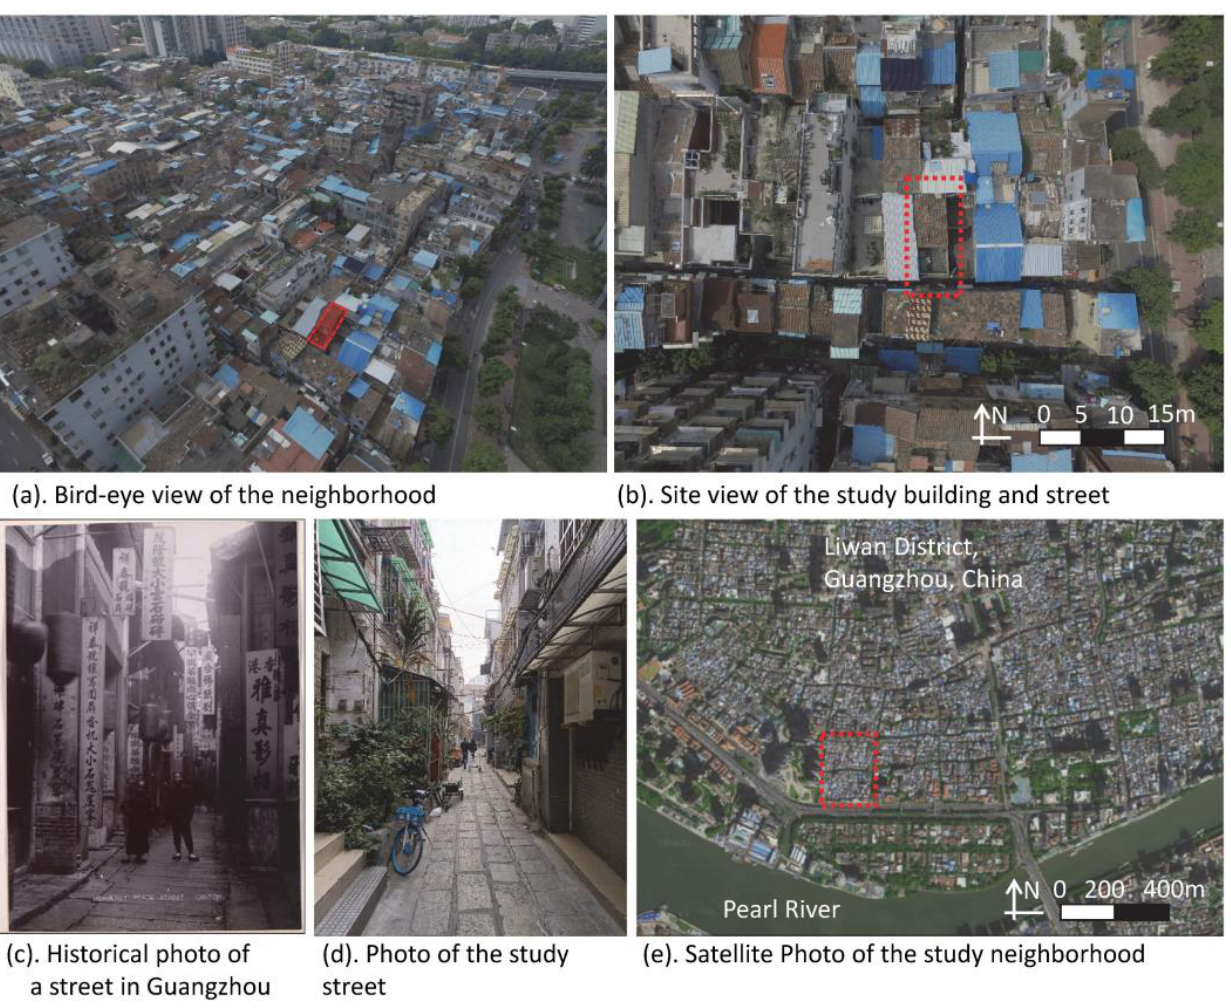
Figure 3. Photos of the study neighborhood (photo (c) was reprinted with permission from [64]. 2010, University of Bristol).